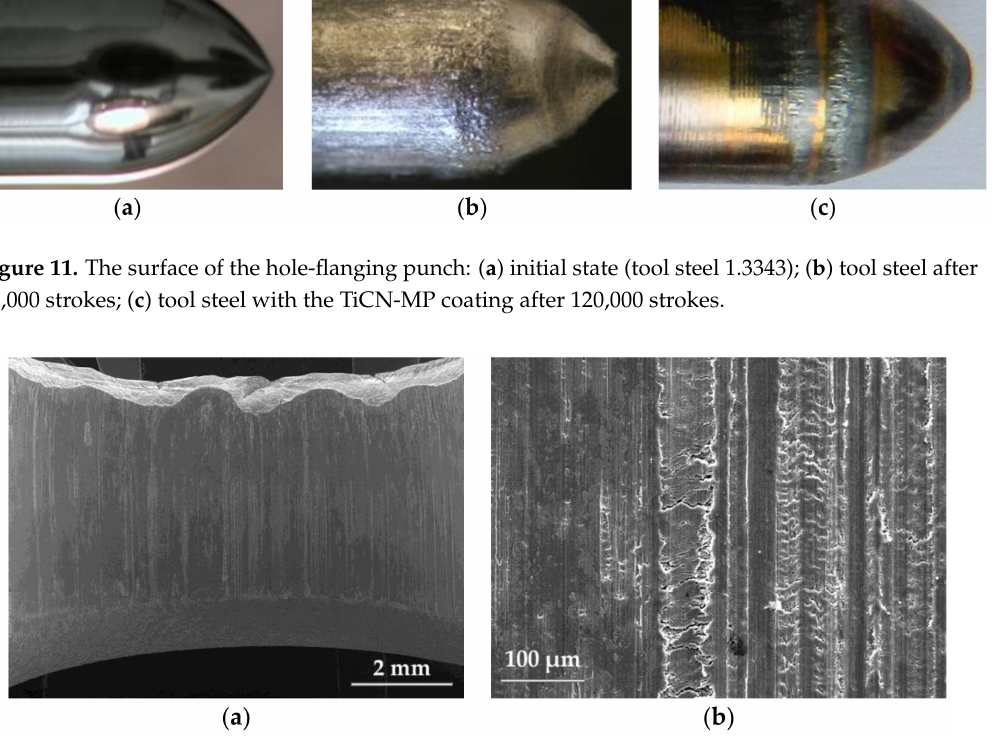
Figure 12. The surface of the hole after flanging with the TiCN coated punch after 120,000 strokes: ( a ) overal view; ( b ) detailed